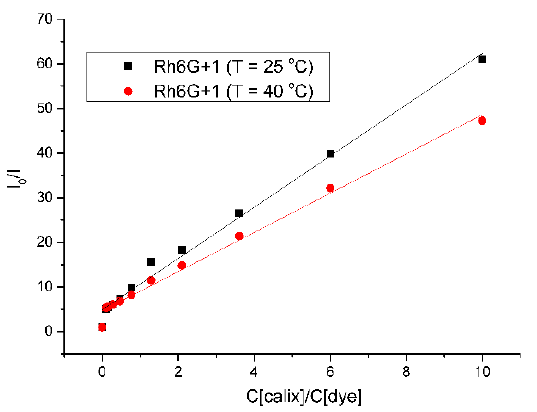
Figure 3. Stern-Volmer plot for Rh6G with macrocycle 1 at different temperatures. C (dye) = 1 μ M, PBS buffer (pH 7.4). Table 1. a Association constants (K a ) of calixarene 1 , 2 and 4 complexes with rhodamine